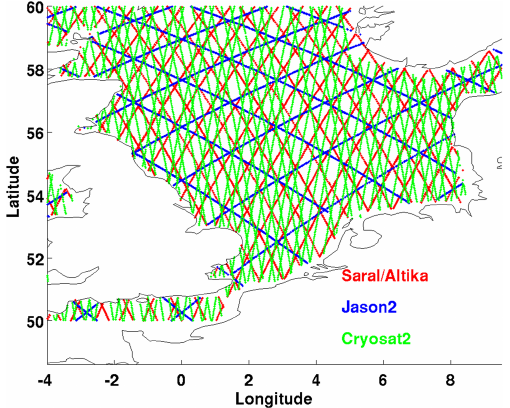
Figure 3. Tracks of all satellites during the study period (1 October until 31 December 2013).